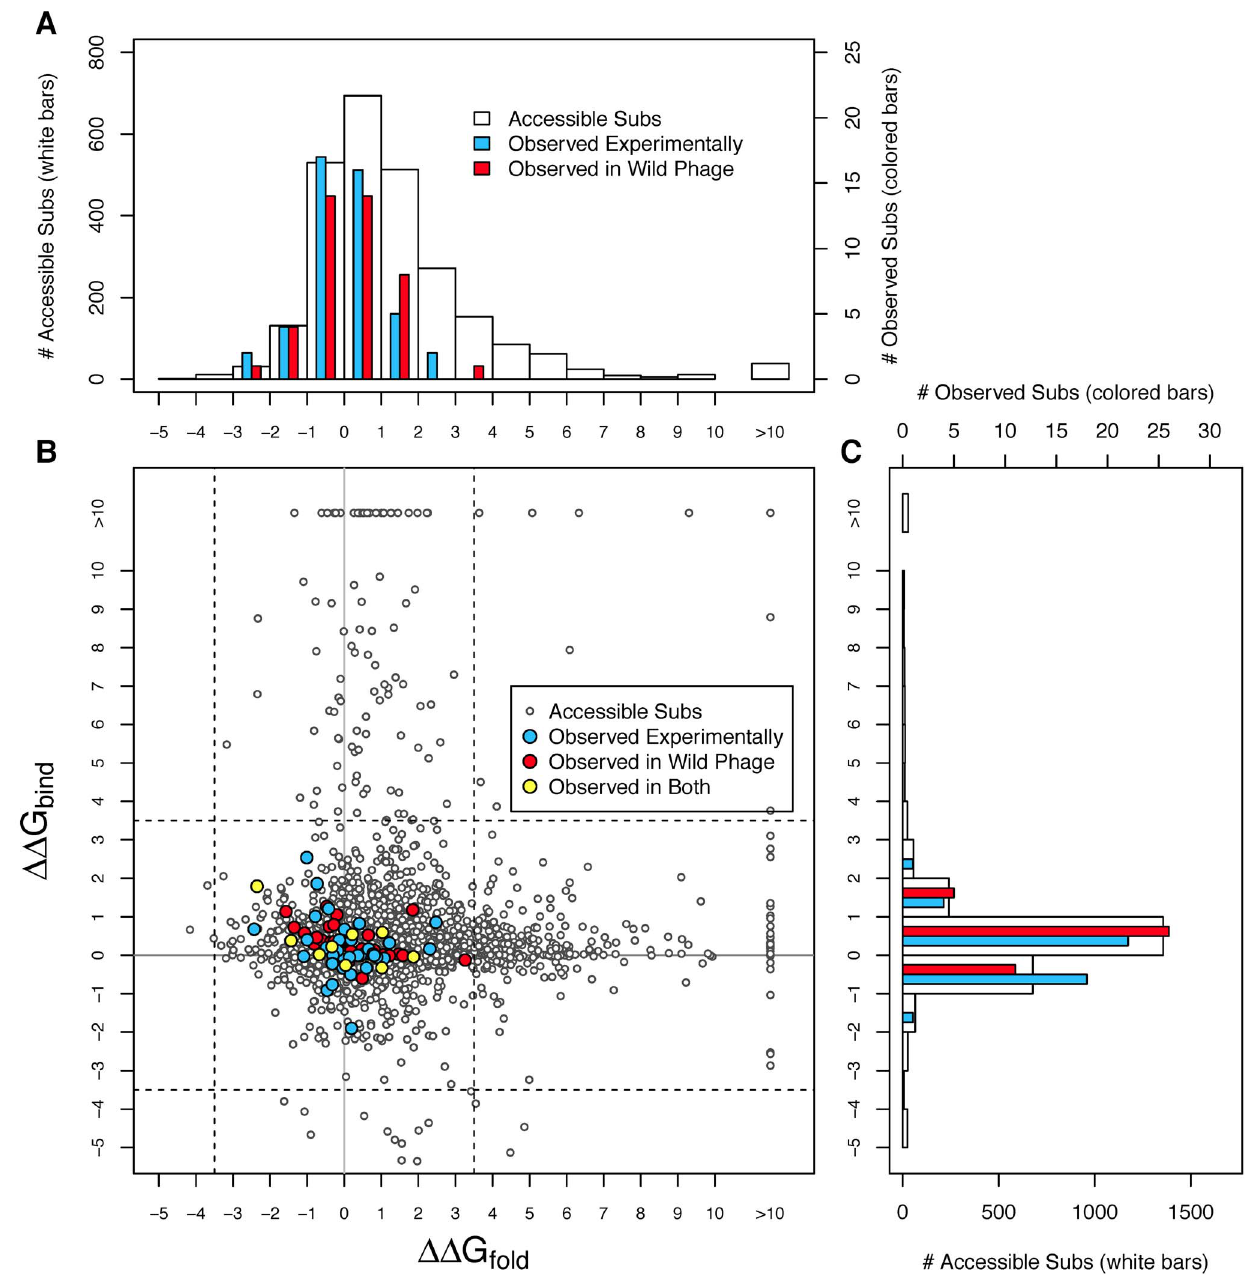
Figure 3. Comparison of stability effects between those accessible and those observed in the experimental and wild phage data. The figure shows that all observed substitutions have small effects on both folding and binding stability. (A) Histogram of DD G fold . (B) Scatterplot of DD G fold vs DD G bind . (C) Histogram of DD G bind . The dotted lines in (B) highlights the zone within which all observed substitutions fall. Note differences in scale between substitutions accessible (white bars) and those observed (red and blue bars) in the two histogram panels.